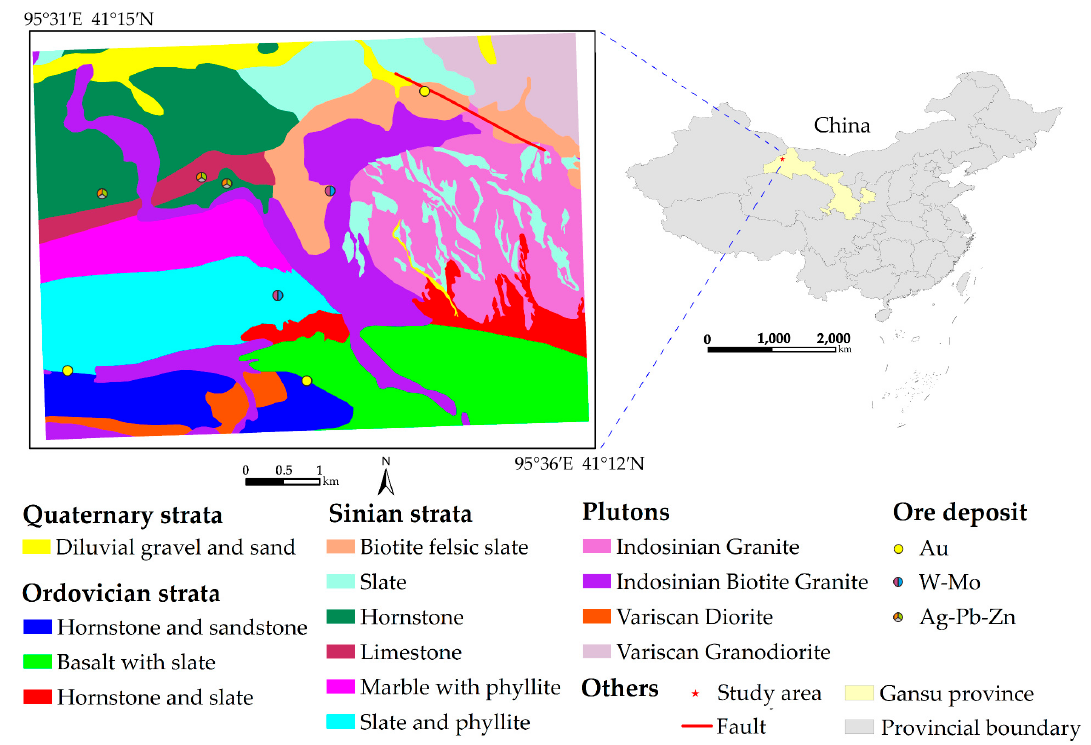
Figure 1. Simplified provincial boundary map of China and the location of the study area. A geological map of the study area is shown on the left, which was derived from an initial geological map at 1:50,000. The geological map is not shown strictly in accordance with the criteria, but in other bright and easily distinguishable colors to more clearly show the spatial distribution and boundaries of litho ‐ units.